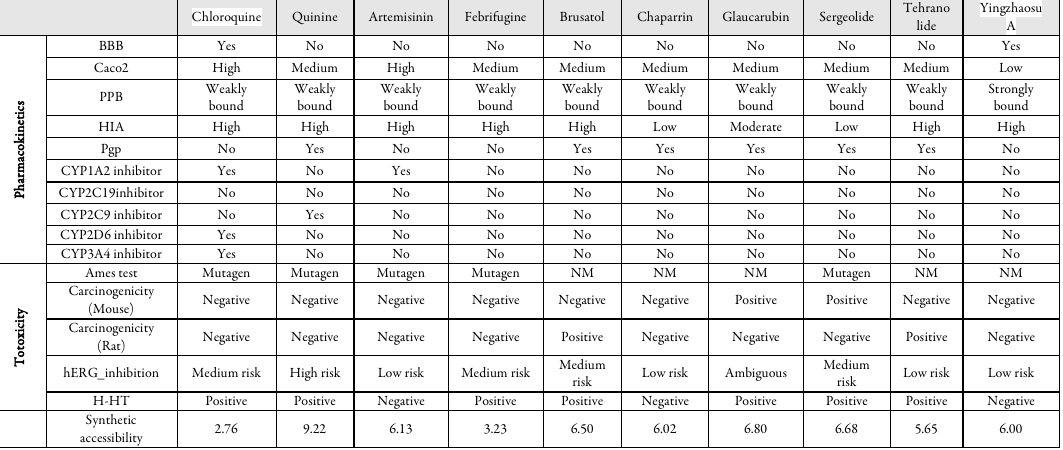
Table 4. ADMET properties of studied phytochemicals Chloroquine